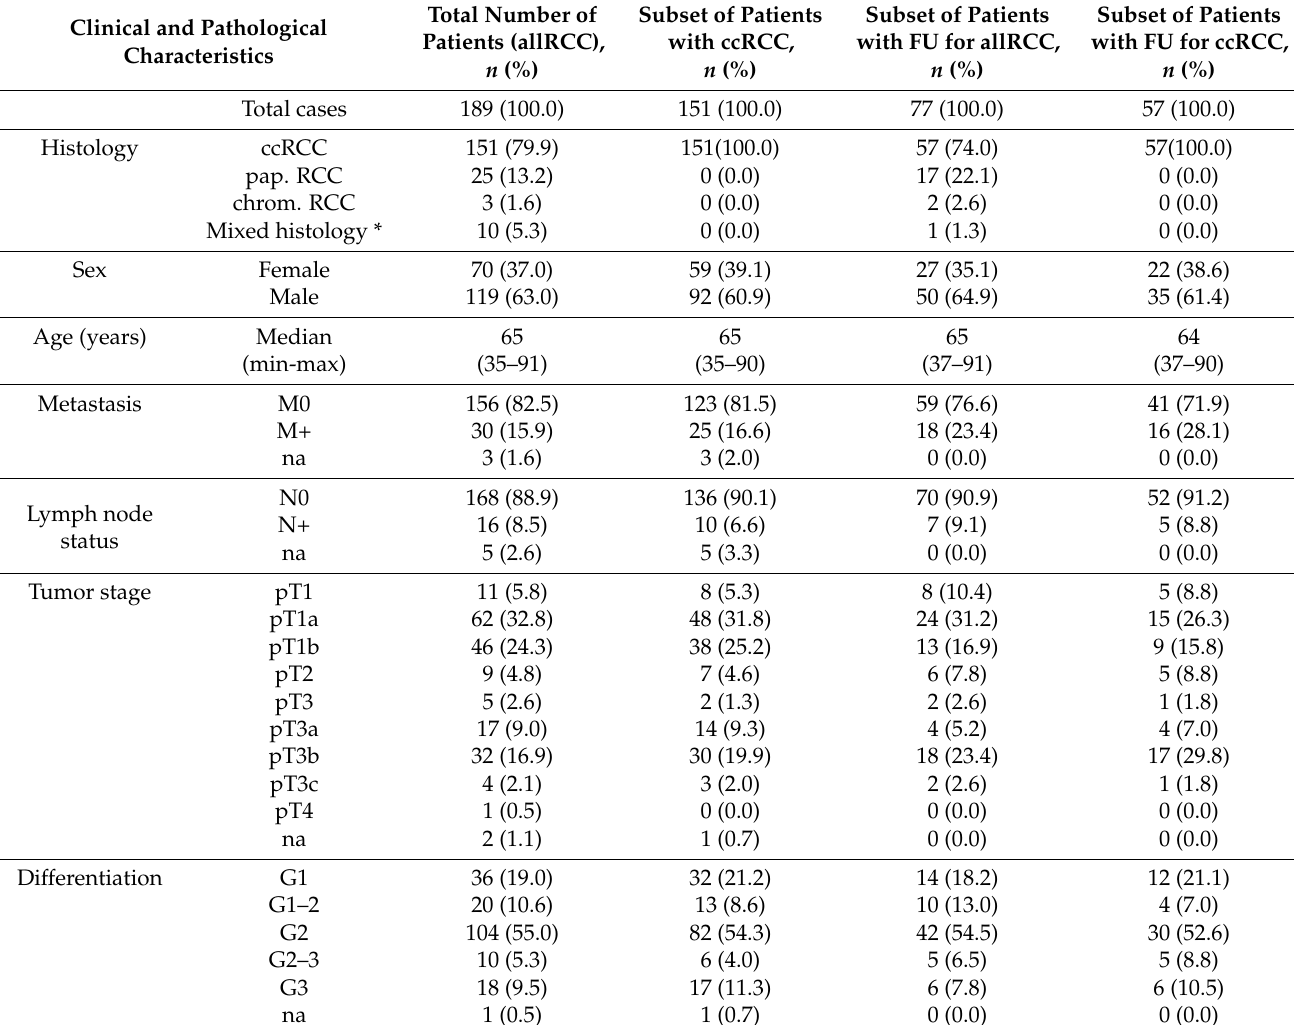
Table 1. Patient’s clinical and histopathologic